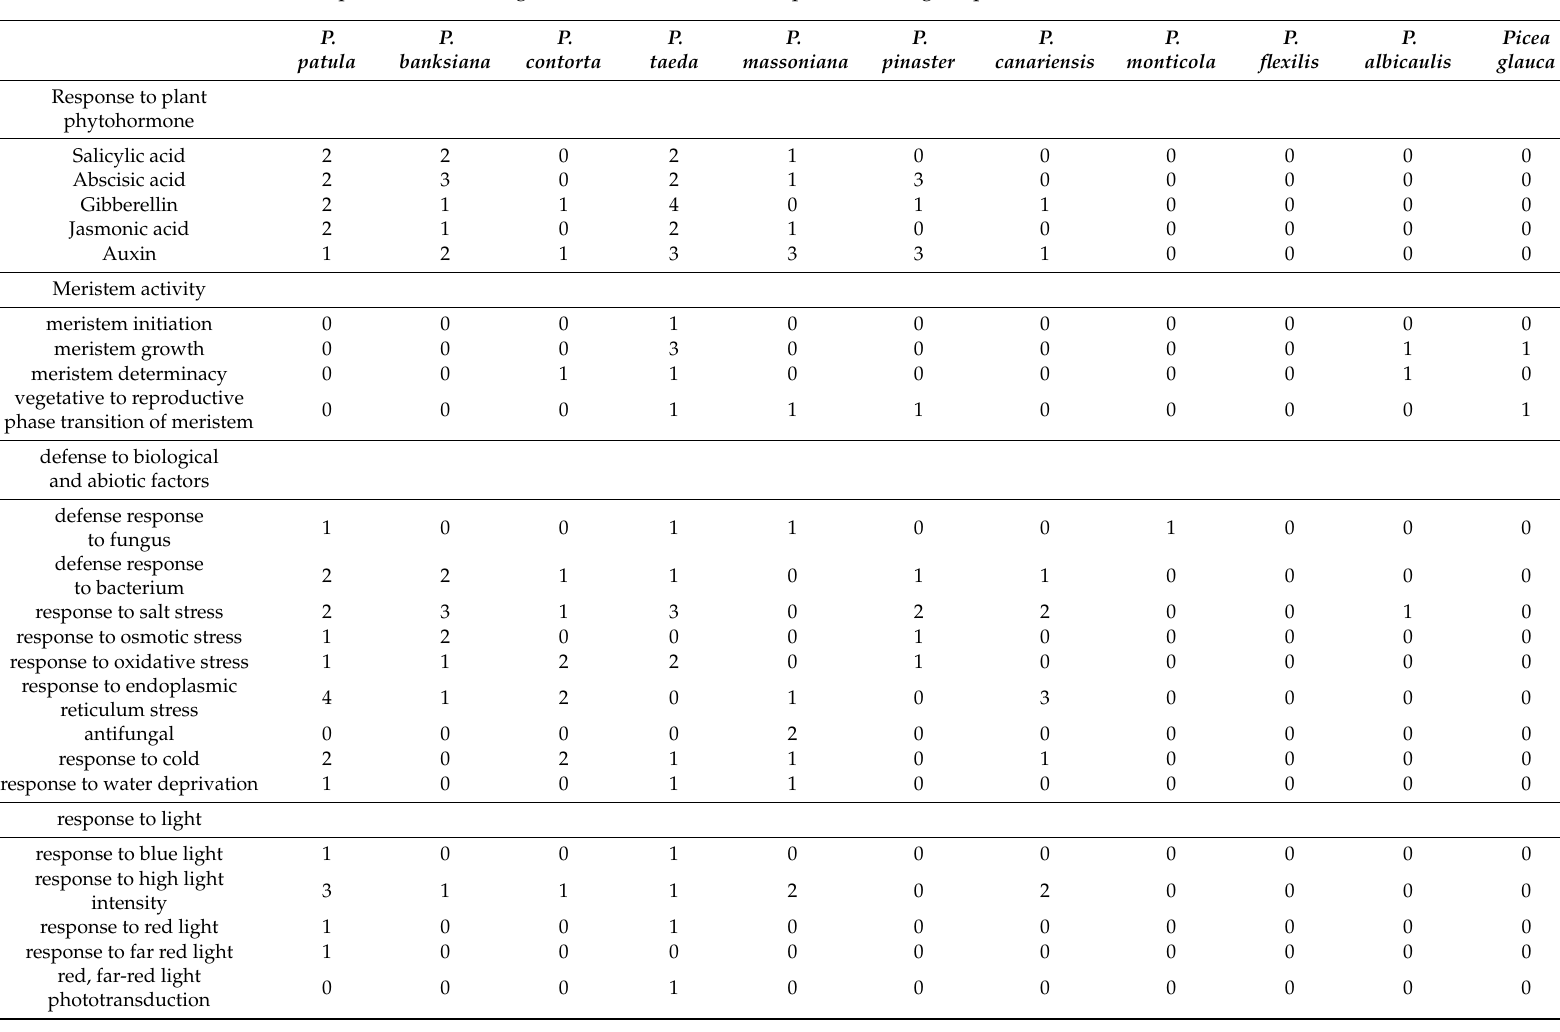
Table 4. The number of positive selection genes annotated to some important biological processes between P. elliottii and 11 other